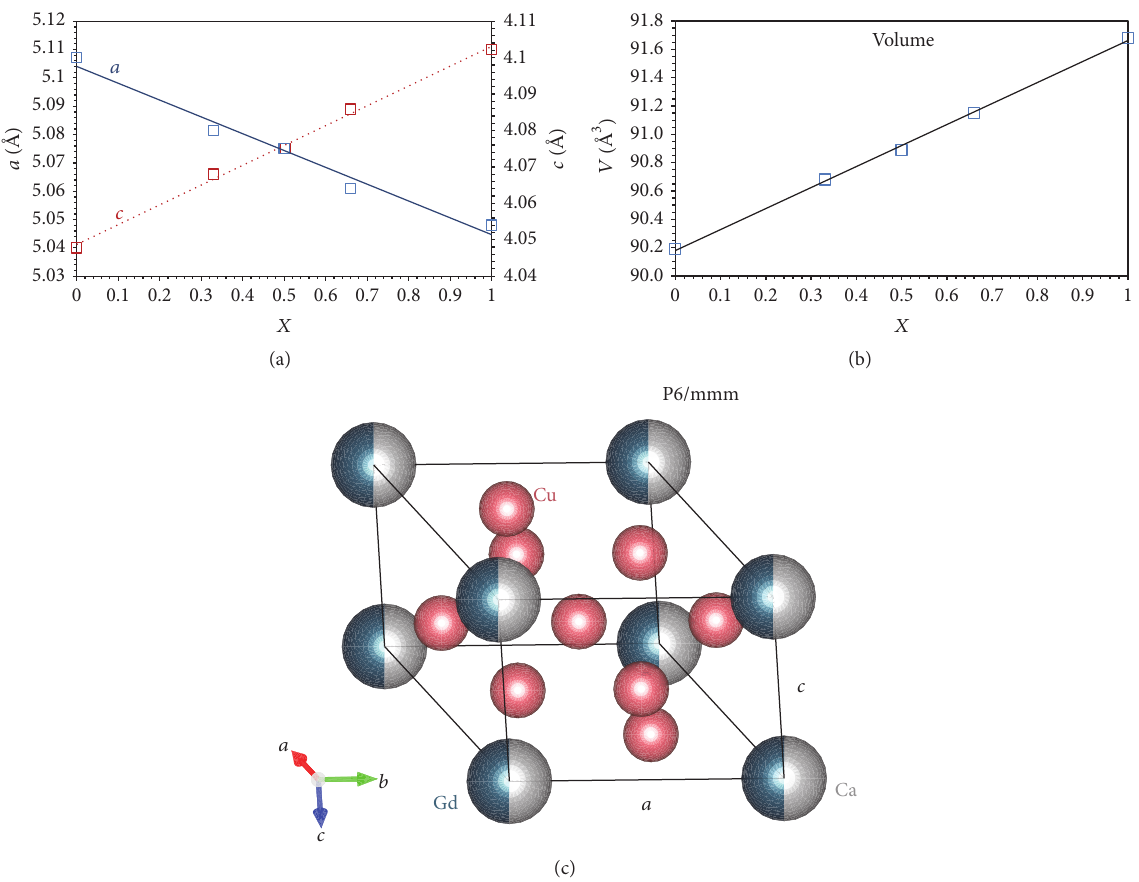
Figure 5: (a) P6/mmm lattice parameters a and c as functions of Ca concentration 𝑥 in Cu 5 Gd 1−𝑥 Ca 𝑥 compounds and (b) corresponding unit cell volume. The lines serve to guide the eyes. Error bars along 𝑥 - and 𝑦 -axes are within the size of the data points; (c) P6/mmm unit cell of Cu 5 Gd 0.5 Ca 0.5